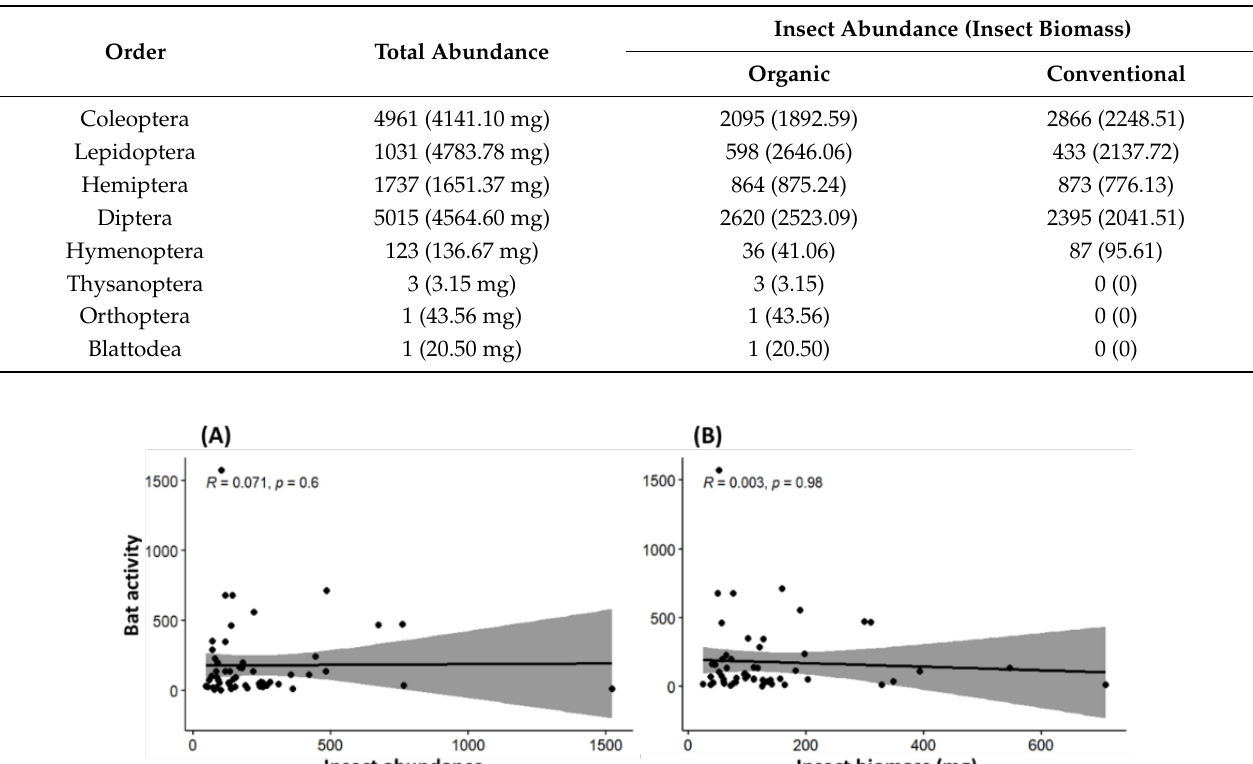
Table 2. Total insect abundance (no. of individuals) and total insect biomass (mg) by rice farming type for each order.